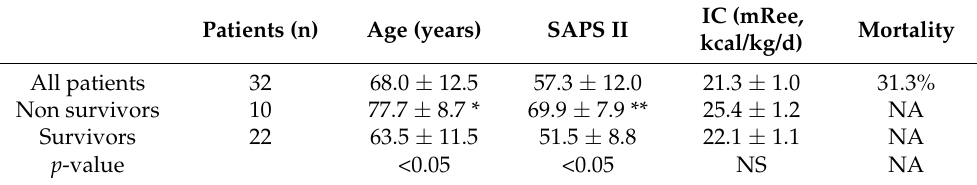
Table legend: *, **: both p < 0.05; NA: non-applicable; NS: non-significant; IC: indirect calorimetry. Non-survivors were significantly older than survivors and had a worse SAPS II score (severity of illness) (* and **, both p <